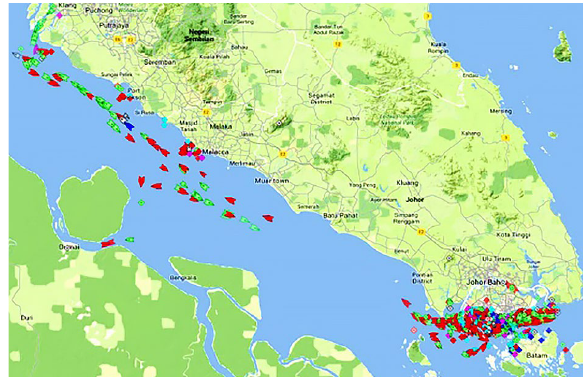
Figure 1. Traffic density in the Singapore Strait area Table 1. Amount of vessels in the Singapore